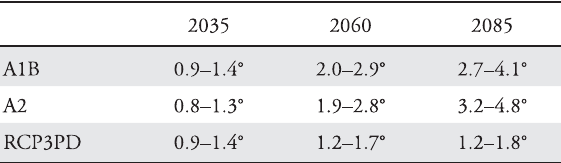
Table 3: "Medium" Estimates of Seasonal Mean TemperatuR